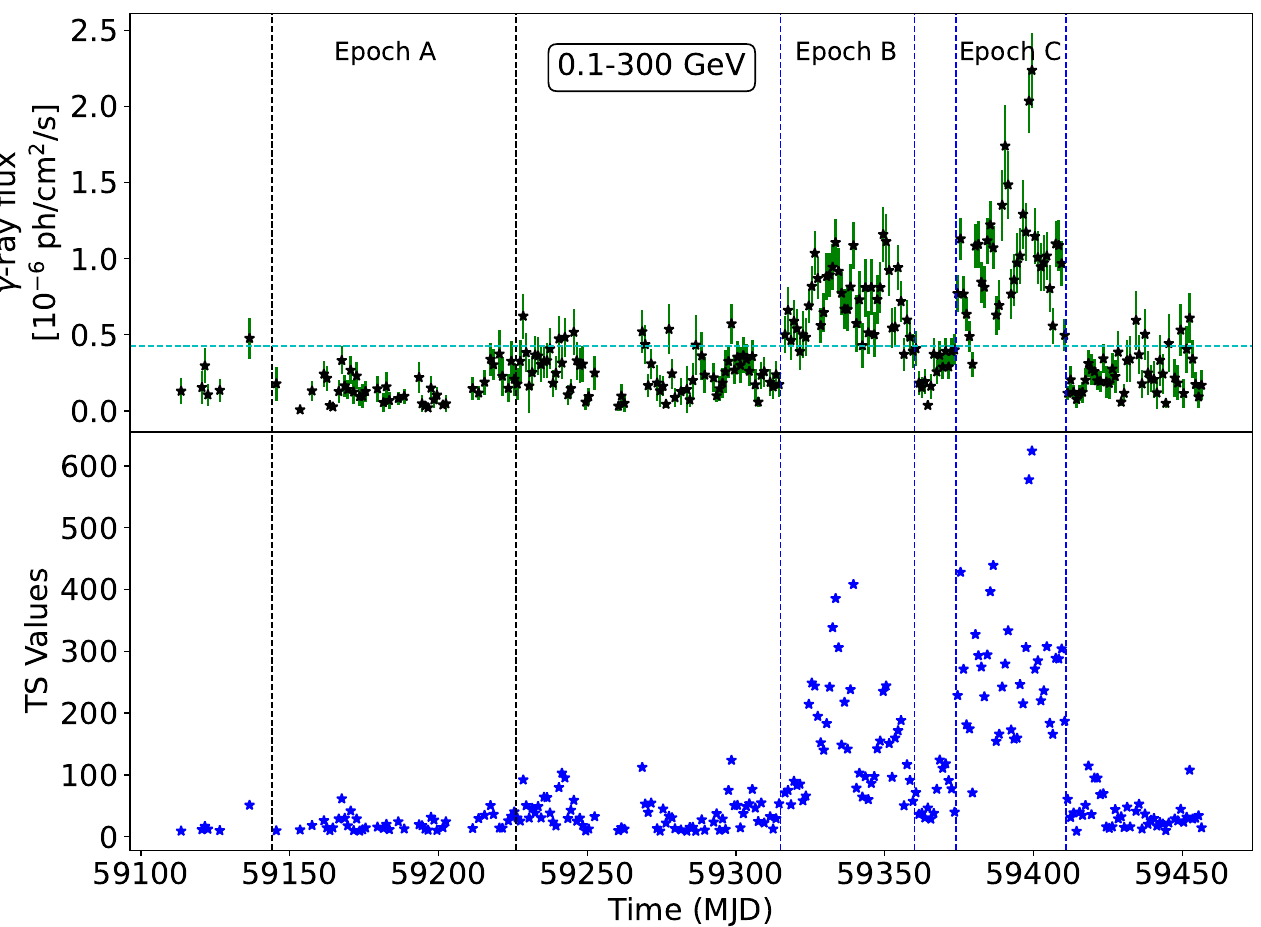
Figure 1. One-day binned γ -ray light curve of Ton 599 ( upper panel ) with the TS values corresponding to each flux value ( lower panel ) . The vertical black lines refer to the quiescent epoch (Epoch A), whereas vertical blue lines refer to the γ -ray flaring epochs (Epoch B and Epoch C). In the upper panel the horizontal cyan line represents the average flux